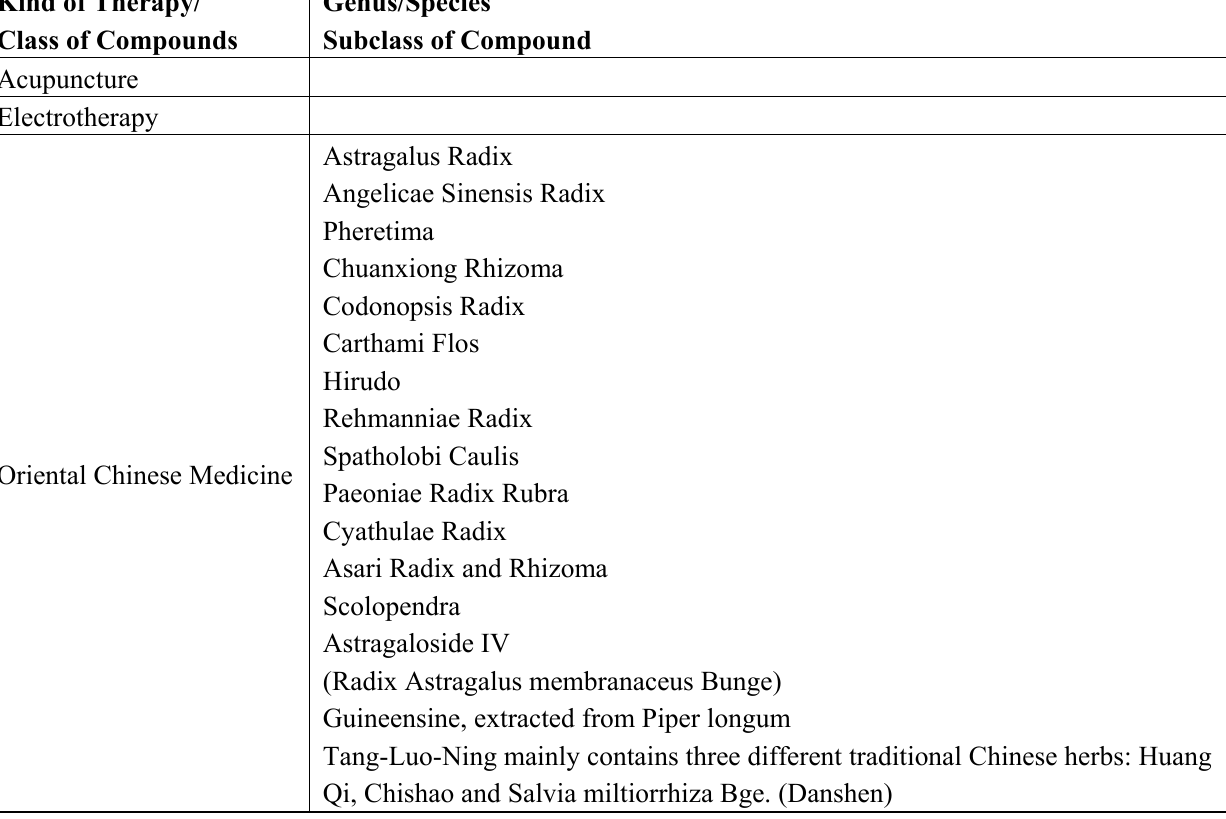
Table 3. Summary of alternative approaches and treatment found to counteract